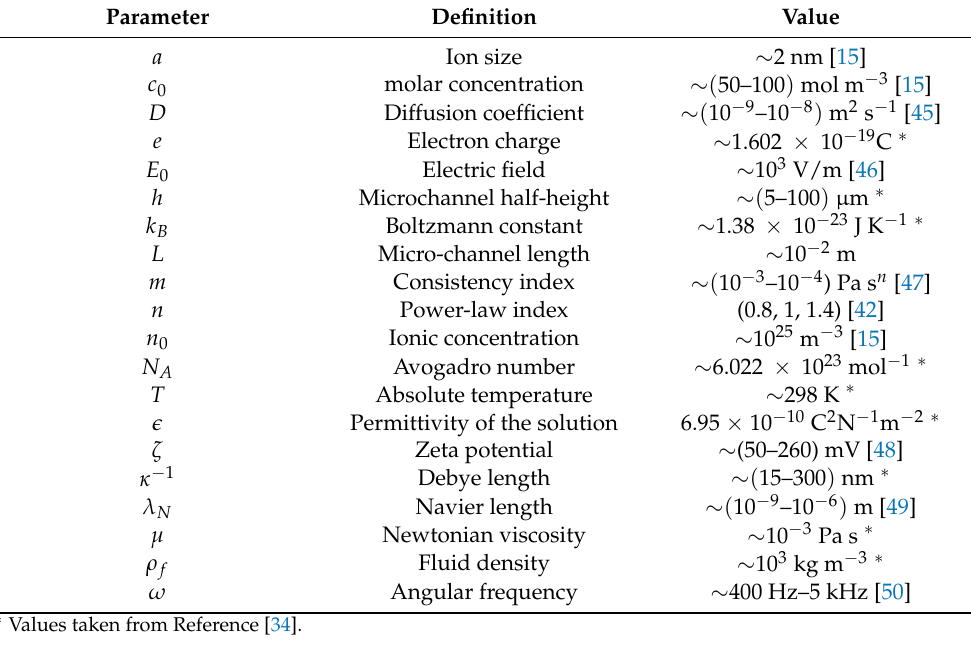
Table 2. Physical properties and geometrical parameters used for estimating the dimensionless parameters from the present analysis.